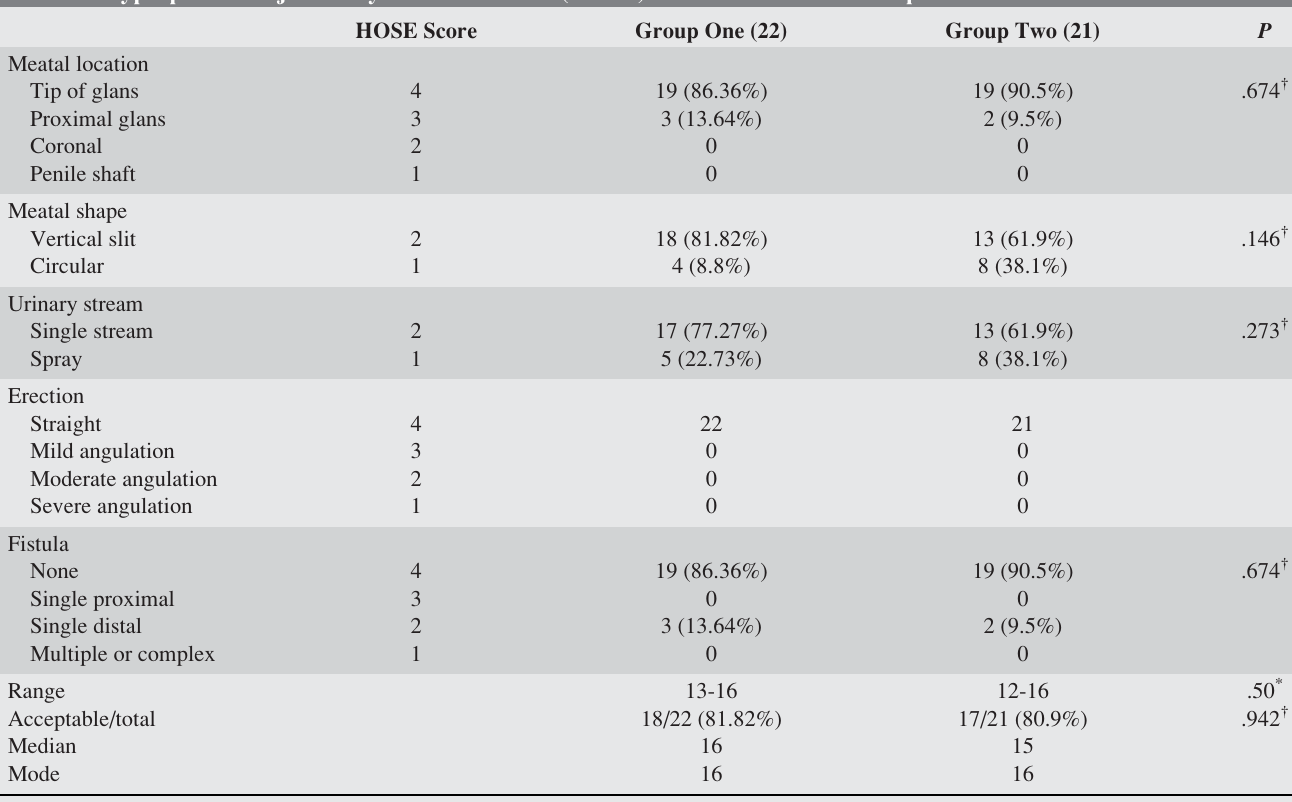
Table 2. Hypospadias Objective System Evaluation (HOSE) Scores of the Two